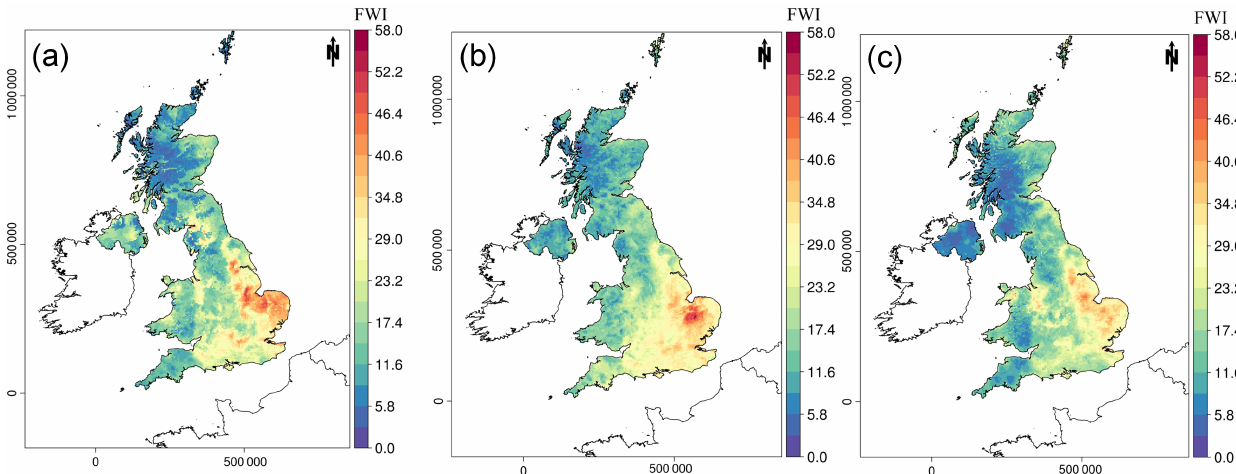
Figure 4. Spatial variation in the 99th percentile of the FWI component of the Canadian Fire Weather Index, as calculated from the 2010– 2013 NWP-derived FWI data set for (a) spring, (b) summer and (c) autumn. The warmer, drier climate of south east England as compared to the wetter, cooler climate of the western and northern parts of the UK causes a distinct gradient in this percentile, which varies by an order of magnitude across the country.